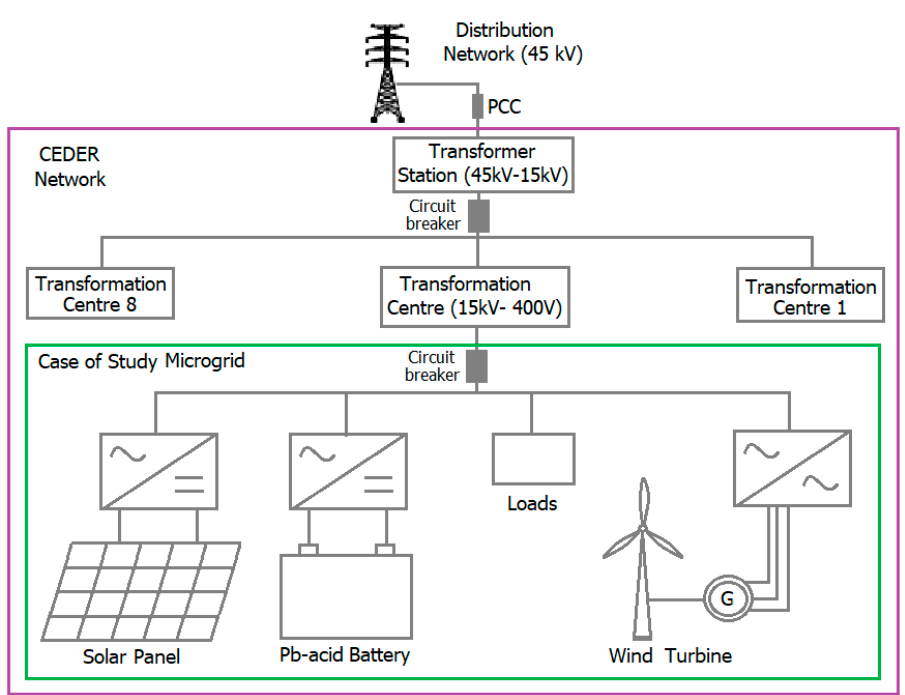
Figure 5. Case of study microgrid. Source: prepared by authors.